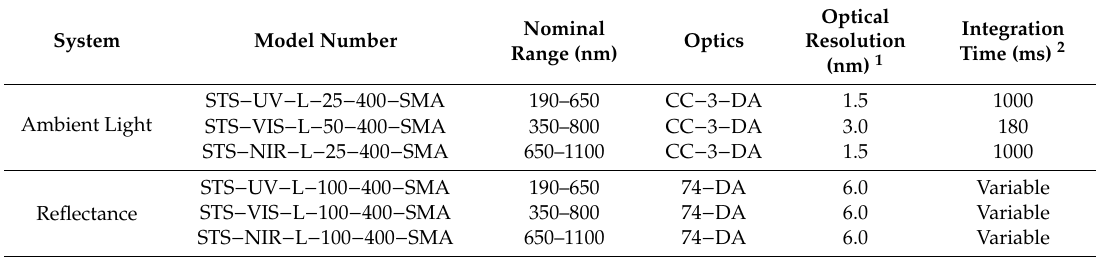
Table 1. Ambient light and reflectance spectrometer specifications.